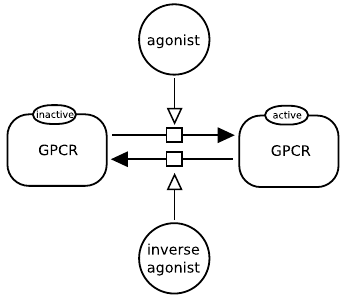
Figure 2.30: The reversible activation of a G-protein coupled receptor.